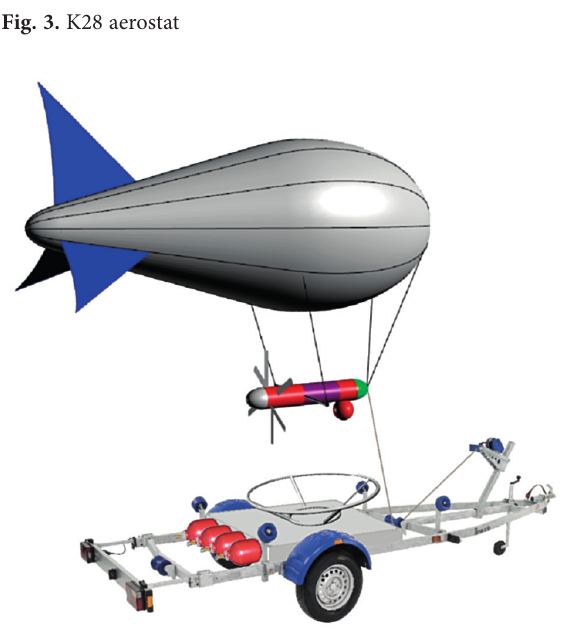
Fig. 4. K4 balloon system utilized for back translation of data transmission, telecommunication and remote observation of the mini-BSP unmanned aircraft